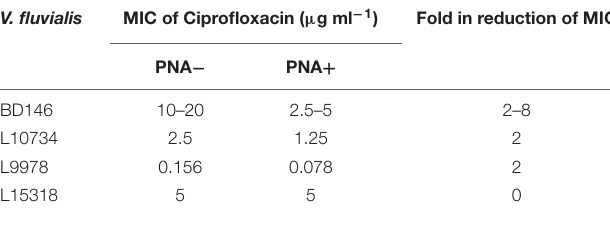
TABLE 2 | Silencing effect of qnrVC5 gene in V. fluvialis